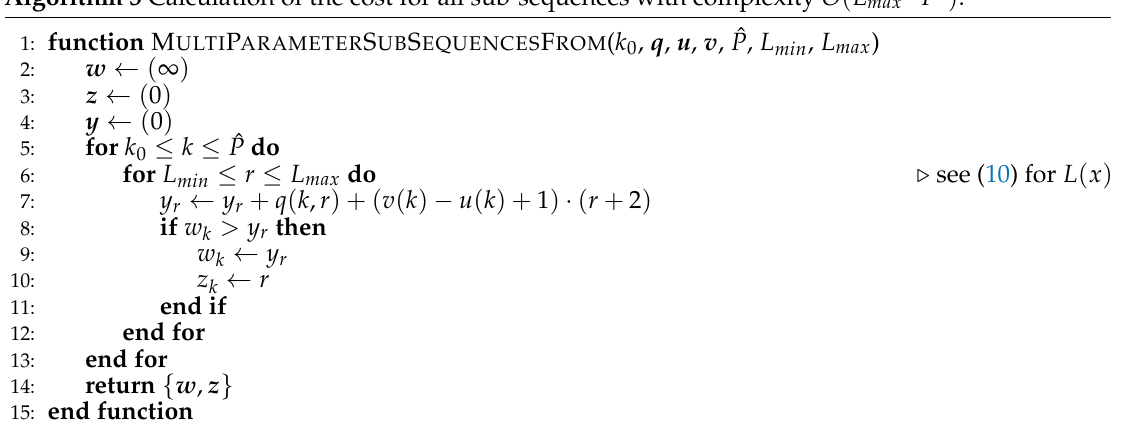
Algorithm 3 Calculation of the cost for all sub-sequences with complexity O ( L max · ˆ P 2 )